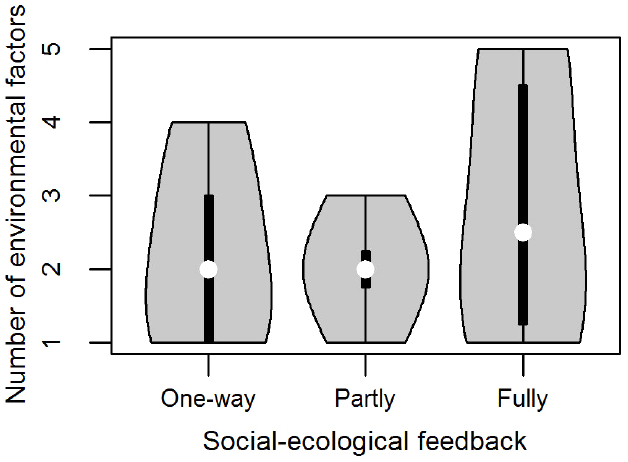
Fig. 4 . Type of social-ecological coupling and the number of environmental factors included in the agent-based model. The white dot indicates the median; the bold bar indicates the first and the third quartiles.